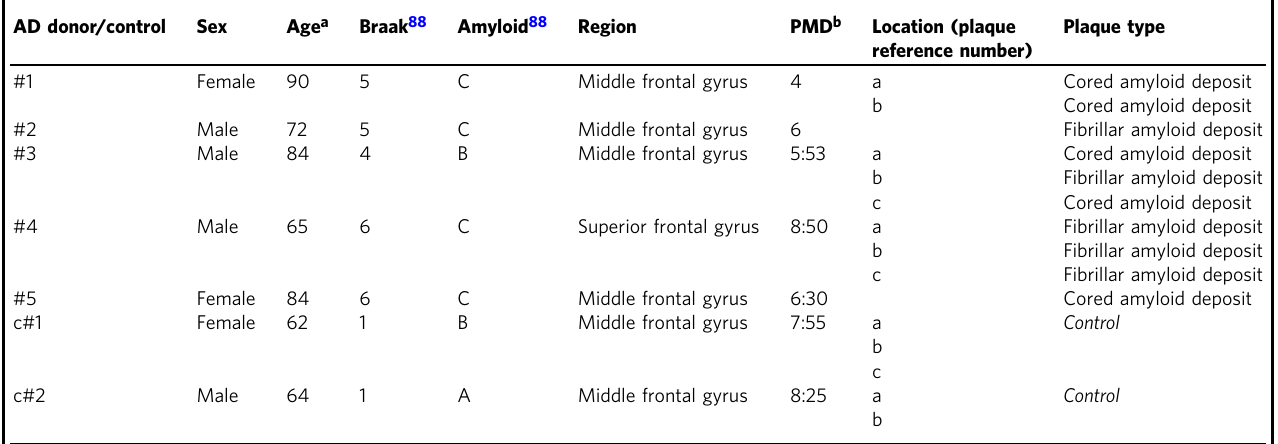
Table 1 Demographics of AD brain donors and imaged plaques.